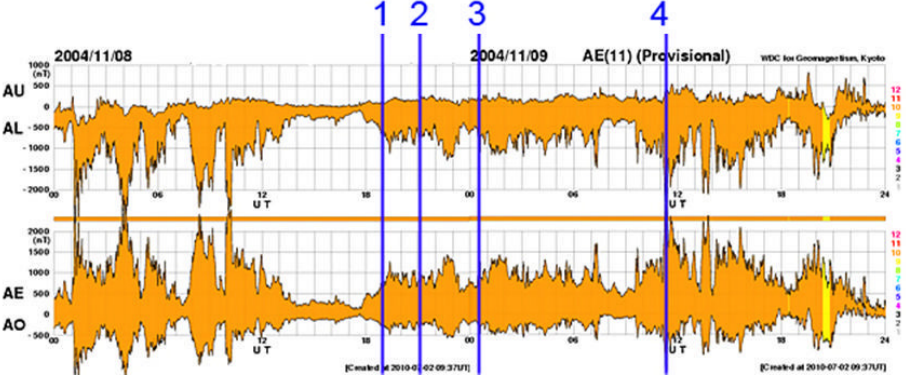
Figure 12. Time variations of AE index from November 8 to November 10, 2004 (http://wdc.kugi.kyoto-u.ac.jp/). The four selected time stamps are marked with vertical blue